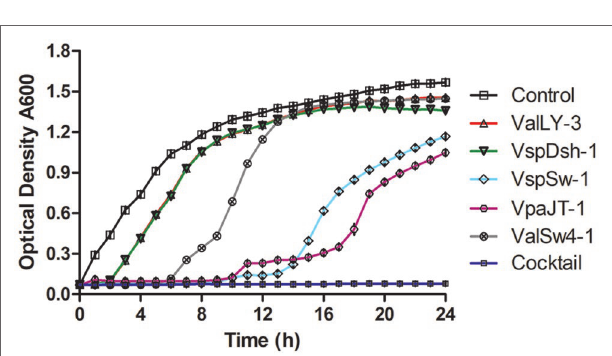
FIGURE 6 | Growth inhibition of Vibrio sp. Va-F3 by the five phages and the phage cocktail in vitro . The MOI was set as 10, the optical density of bacterial solution as approximately 0.5 (OD 600 , 10 8 CFU/ml), and the concentrations of the phages (ValLY-3, VspDsh-1, VspSw-1, VpaJT-1, ValSw4-1, and their cocktail) as 2 × 10 9 PFU/ml. Each point represents the average result of three replicates, and error bars represent standard deviations. According to the curve, we can calculate the frequency of phage resistant bacteria in the population to a given phage. First, we calculated the number of the phage resistant bacterial cells starting to grow during the incubation using the formula: Nm = Nt(the number of bacterial cells at OD 600 = 1)/2 [tOD600(the time bacteria grow to OD600 = 1)/td(bacterial cell doubling time)] , and then f(the frequency of phage resistant bacteria) = Nm(the number of bacterial mutant cells at beginning)/N0(the number of all bacterial cells at beginning). We determined N0 = 2 × 10 8 CFU/ml and td = 60 min; at OD 600 = 1, tOD 600 = 5 h for control, tOD 600 = 8 h for ValLY-3 and VspDsh-1, tOD 600 = 11 h for ValSw4-1, tOD 600 = 20 h for VspSw-1, and tOD 600 = 23 h for VpaJT-1; Nt = 10 9 . Therefore, we calculated the f(ValLy-3 and VspDsh-1) = 0.20, f(ValSw4-1) = 0.002, f(VspSw-1) = 4.77E-06, f(VpaJT-1) = 5.96E-07. During the experiment in 24 h, we were not able to determine the growth of the bacterial cells when treated with the cocktail, suggesting the frequency of the cocktail resistant bacterial cells is extremely